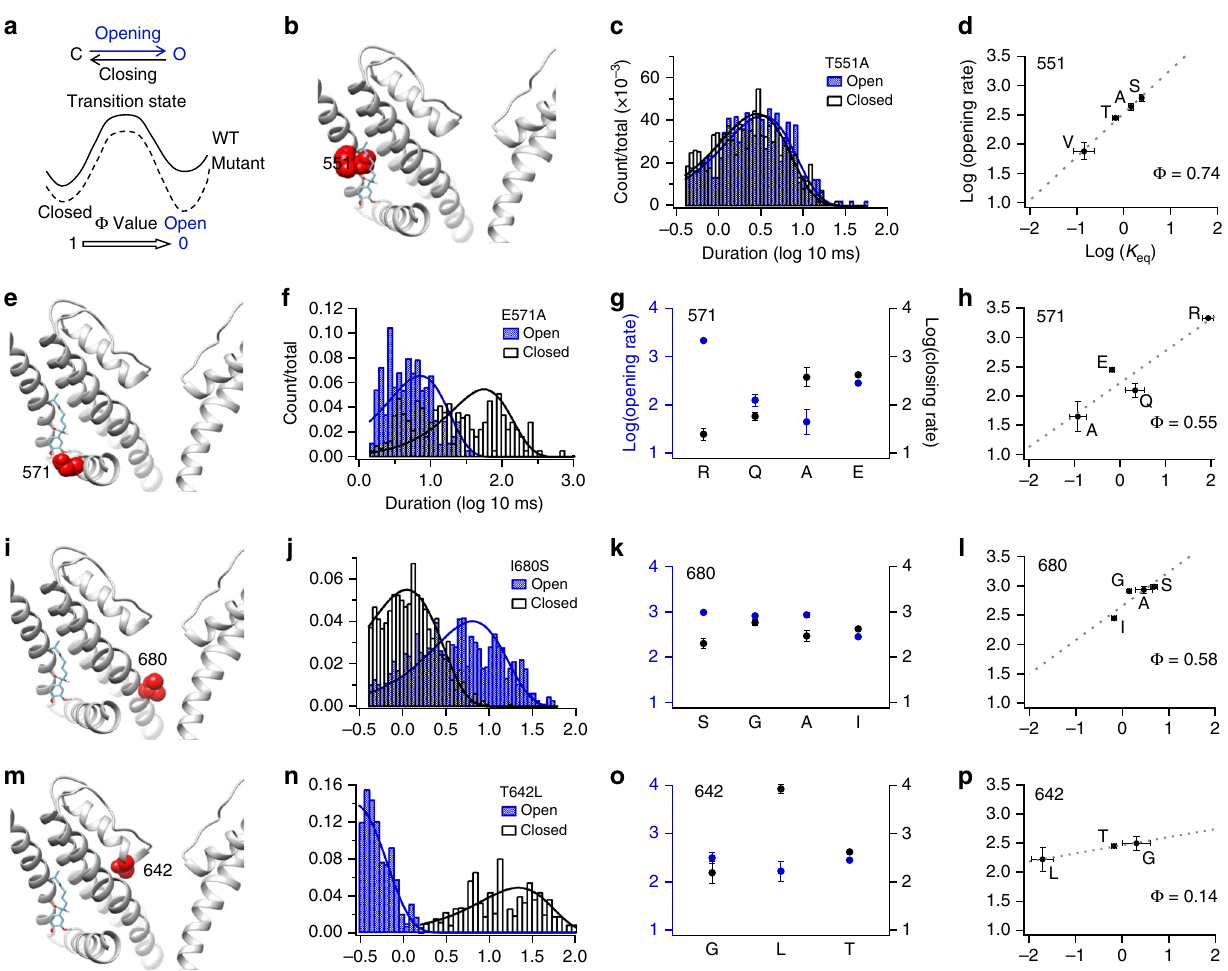
Fig. 4 Φ -analysis of representative residues on TRPV1. a The free energy landscape of a closed-to-open transition. Point mutations, depending on its location, have asymmetrical effects on the free energies of closed and open state, which can be re fl ected in the kinetics of single-channel events. b T551 site (red) locates within the capsaicin-binding pocket. c Distribution of the opening (blue) and closing (gray) events duration in the log scale. d Brønsted plot to determine the Φ value for the T551 site. For each mutation at the same site, 3 – 5 independent single-channel recordings were analyzed. e – h The E571 site on the S4 – S5 linker shows an intermediate Φ value of 0.55. i – l The I680 site near the S6 bundle crossing also shows an intermediate Φ value of 0.58. m – p The T642 site near the selectivity fi lter shows a low Φ value of 0.14. All statistical data are given as mean ± 3 showed both smaller pore radii and smaller predicted conductance as compared to the open model (Supplementary Figure 2e and 2f).